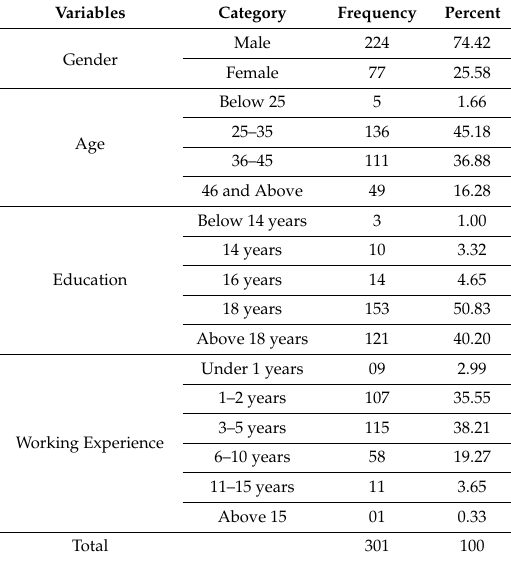
Table 1. Participants’